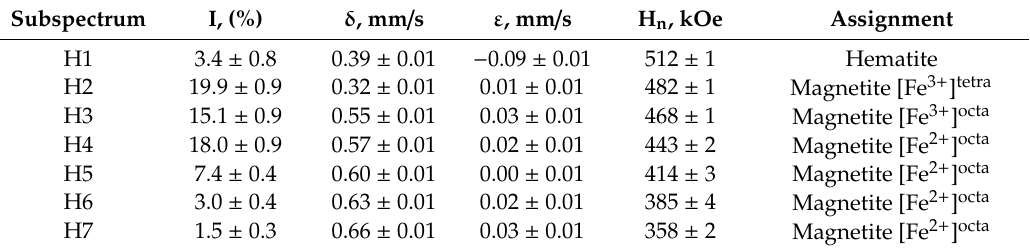
Table 1. Hyperfine parameters of the magnetic fraction obtained from the MS spectrum of the fly ash FA1.